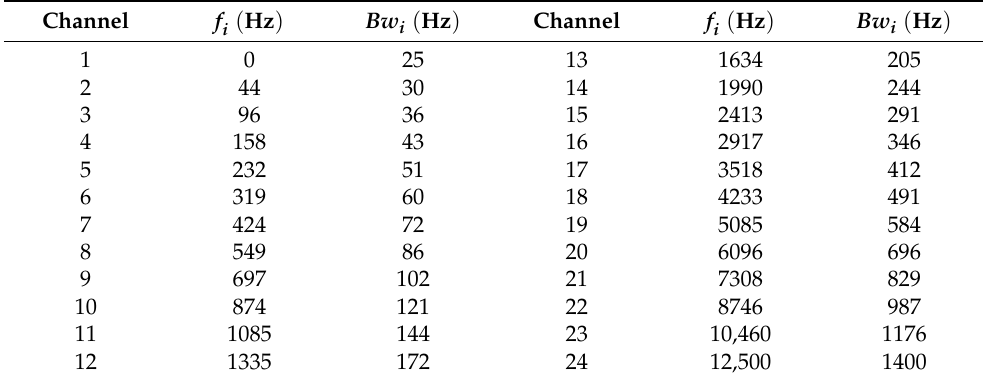
Table 1. The center frequency f i and bandwidth Bw i of the gammatone filter